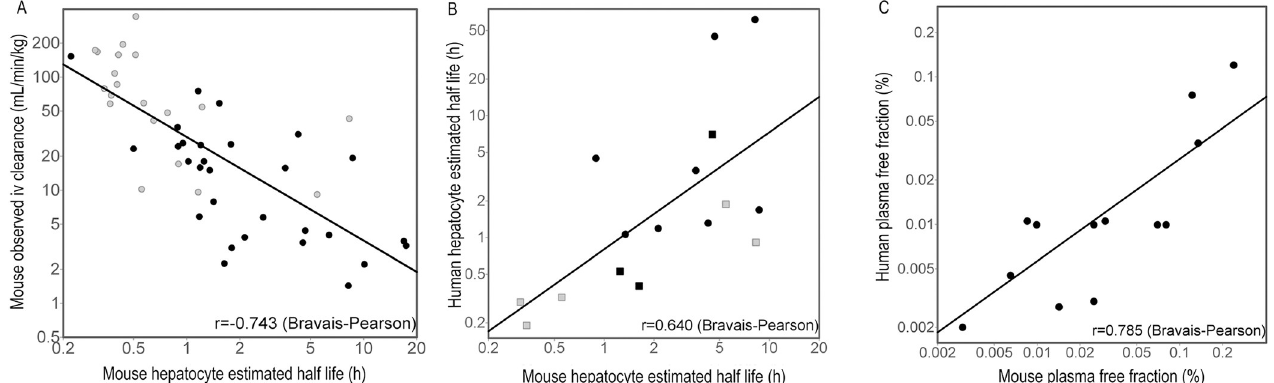
Fig 7. Correlations between various mouse and human in vitro properties. A In vitro half-life in mouse hepatocytes calculated from the percentage of test compound remaining after a set incubation time (30 minutes, grey circles or 90 minutes, black circles) compared with observed clearance measured in mouse after iv administration at 0.5 mg/kg co-administered in groups of five. B In vitro half-life in mouse or human hepatocytes calculated as described for panel A (incubation time in human hepatocytes 30 minutes, squares or 90 minutes, circles). C Plasma protein binding (expressed as free fraction), measured at 10uM. Despite difficulties in accurate measurement due to very high levels of protein binding, the data is consistent with equal levels of protein binding in mouse and human plasma.